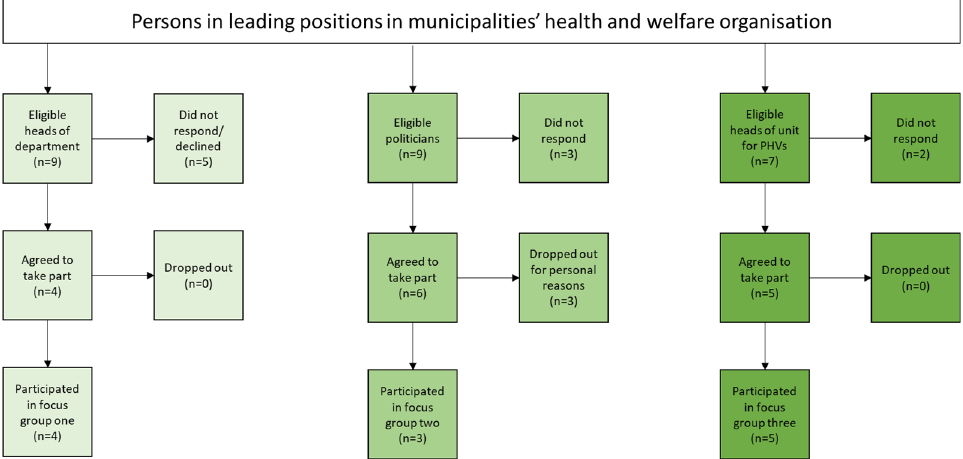
Figure 1. Overview of the sampling procedure. Three separate focus groups with heads of department for health and welfare, politicians responsible for the political health and welfare committee, and heads of unit for the preventive home visits (PHVs) were conducted. Table 1. Characteristics of the